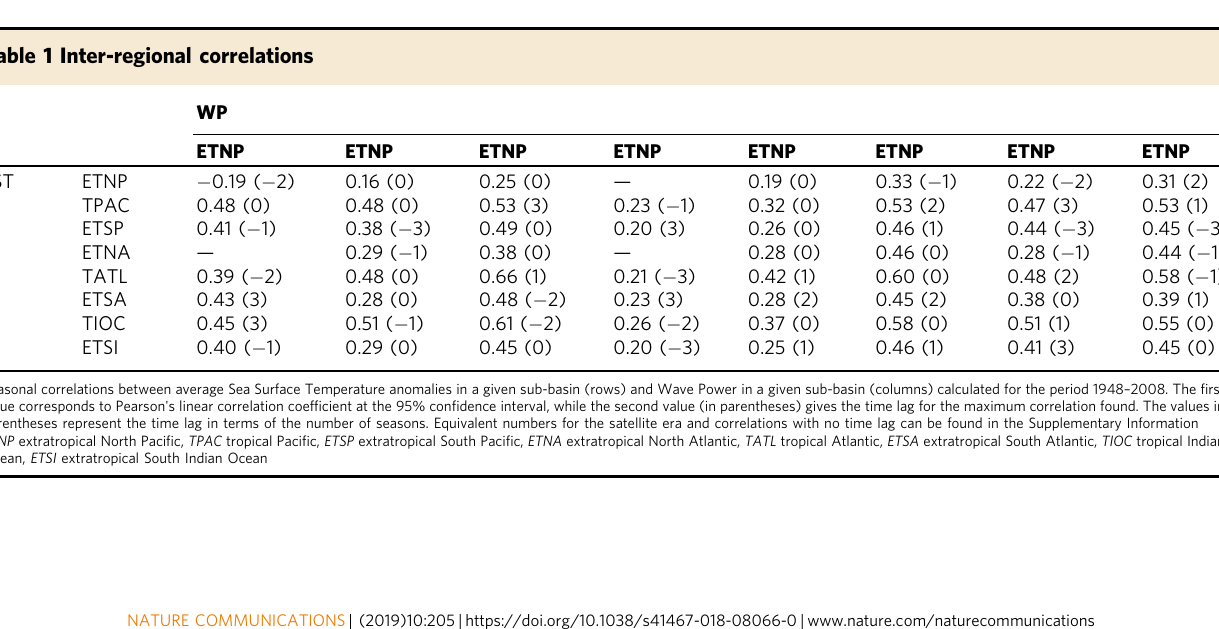
Table 1 Inter-regional correlations